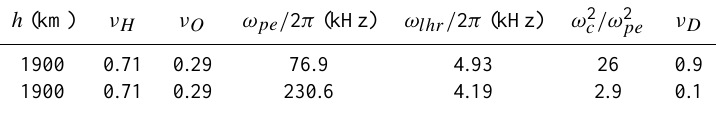
Table 2. The parameters of Table 1 are presented at the altitude of 1900km for two values of the relative content ν D of the negative ions O − (last column).